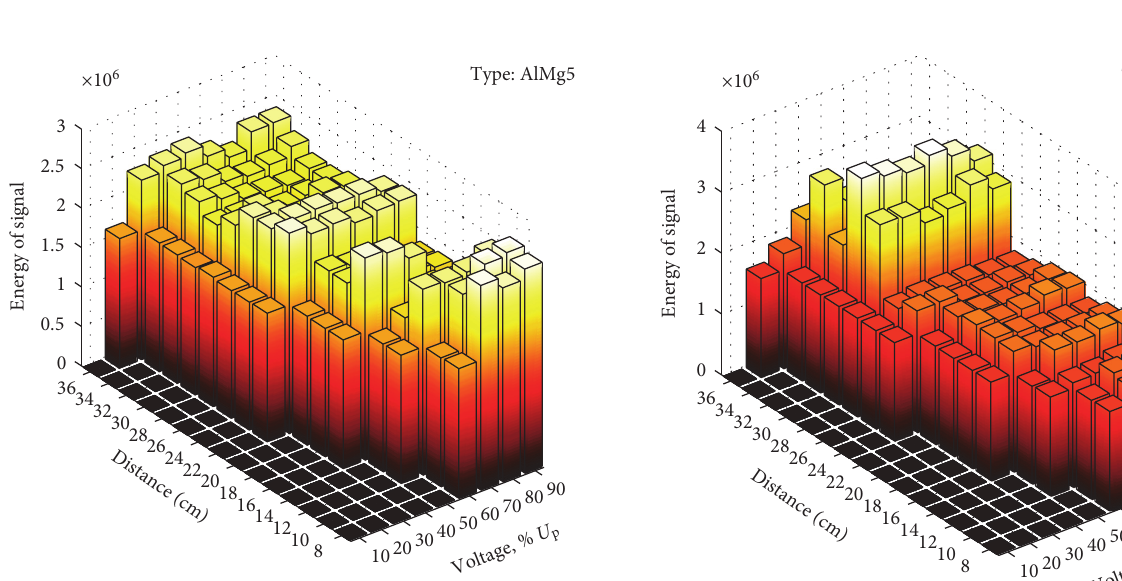
Figure 4: Dependency of voltage and distance on the value of energy of signal calculated for optical spectra emitted by corona around the Al line.